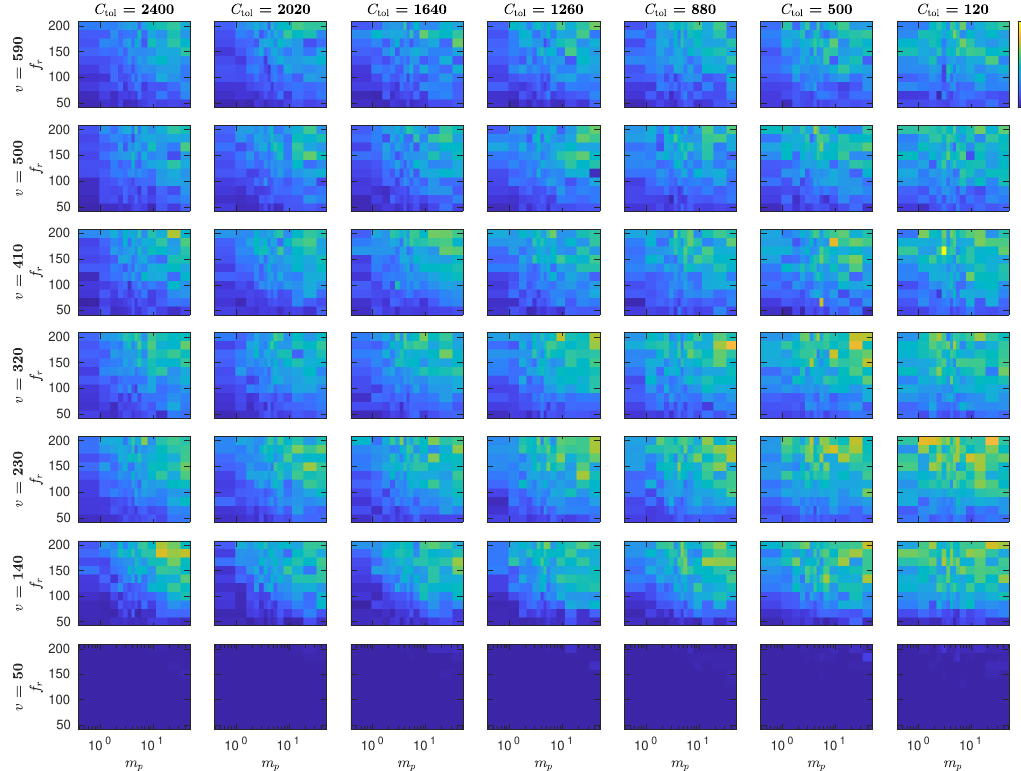
Figure A1. Successful mating percentage using MothPy [75] as described in Appendix C. Velocities v are measured in cm/s; female pheromone amounts m p are measured in pg; pheromone puff release rates f r are measured is s − 1 ; and pheromone detection thresholds C tol are measured in pg/cm 2